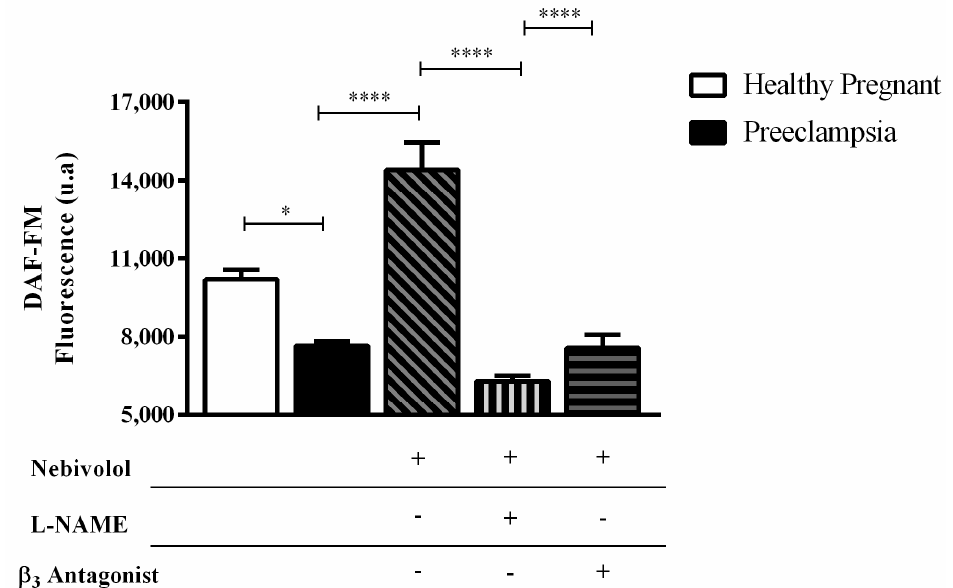
Figure 1. NO fluorescence intensity measured by DAF-FM. HUVECS were incubated with 10% ( v / v ) plasma from healthy pregnant (HP, white column) or preeclampsia (PE, black column) ( n = 10 per group) and treatments for 4 h. Values are means ± S.E.M. Comparisons between groups were realized, assed by One-Way ANOVA followed by Holm-Sidak test. * ( p < 0.05) HP vs PE; **** ( p < 0.0001) PE vs PE + Nebivolol; PE + Nebivolol vs PE + L-NAME + Nebivolol; PE + Nebivolol vs PE + β 3 antagonist + Nebivolol.